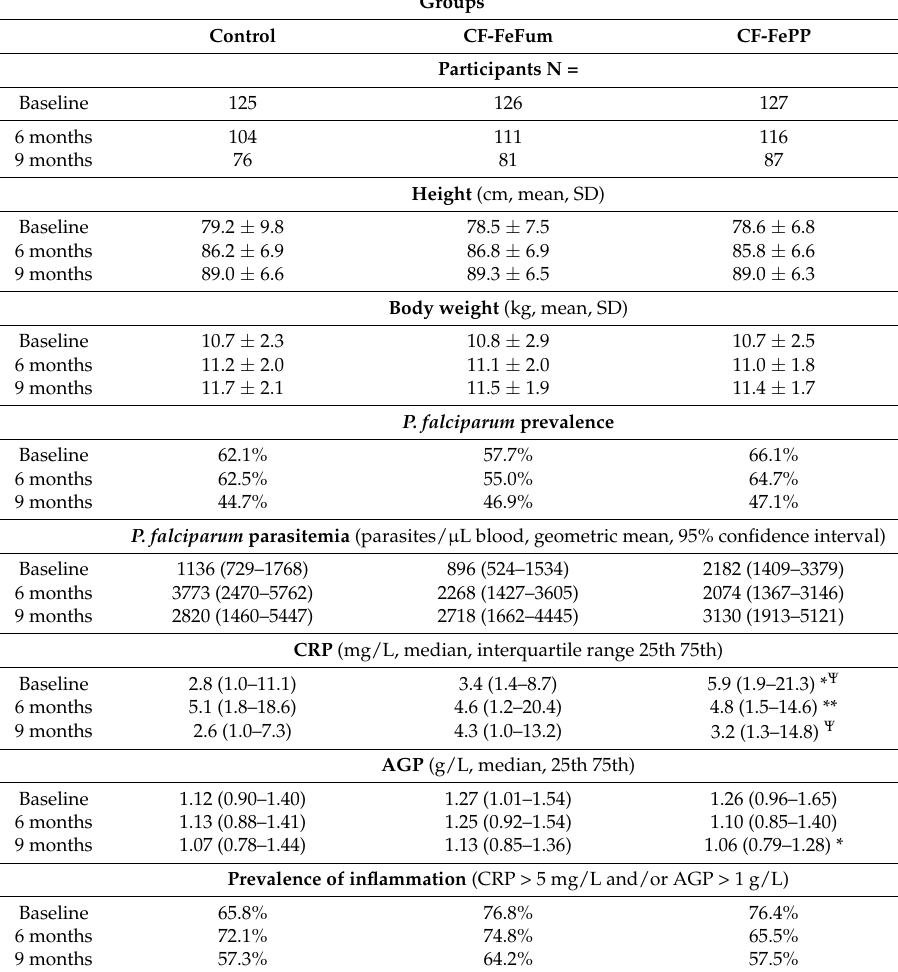
Table 1. Between group comparison of anthropometric measures, P. falciparum infection prevalence, P. falciparum parasitemia, and inflammation biomarkers and prevalence at baseline, six months, and nine months in 12- to 36-month-old Ivorian children fed iron fortified complementary food (CF) containing NaFeEDTA combined with either ferrous fumarate (FeFum) or ferric pyrophosphate